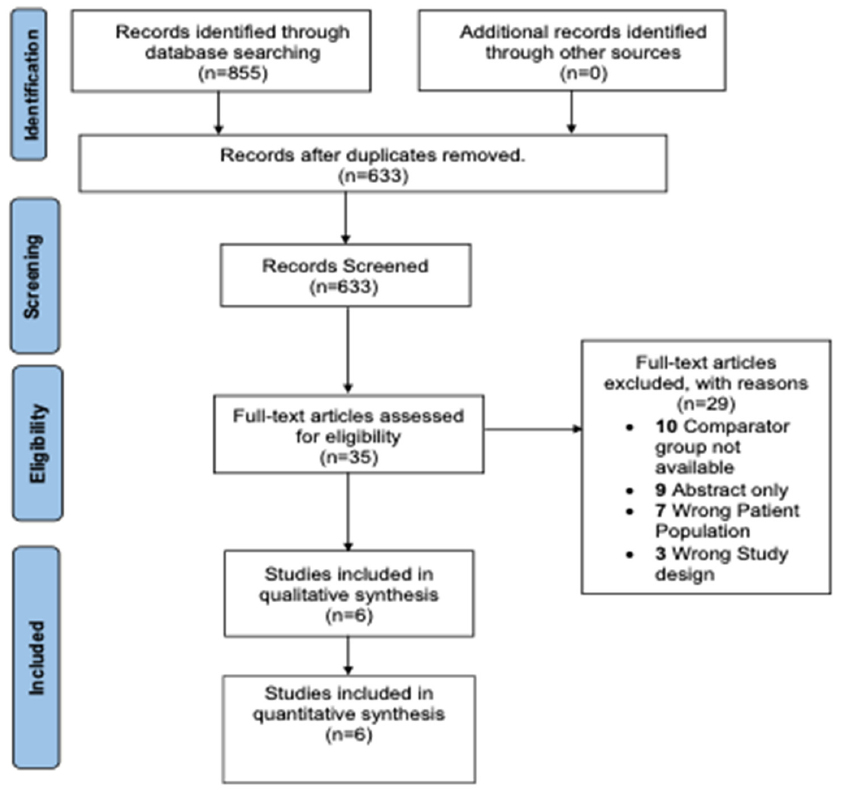
Figure 1. Preferred Reporting Items for Systematic Reviews and Meta-Analyses flow diagram.